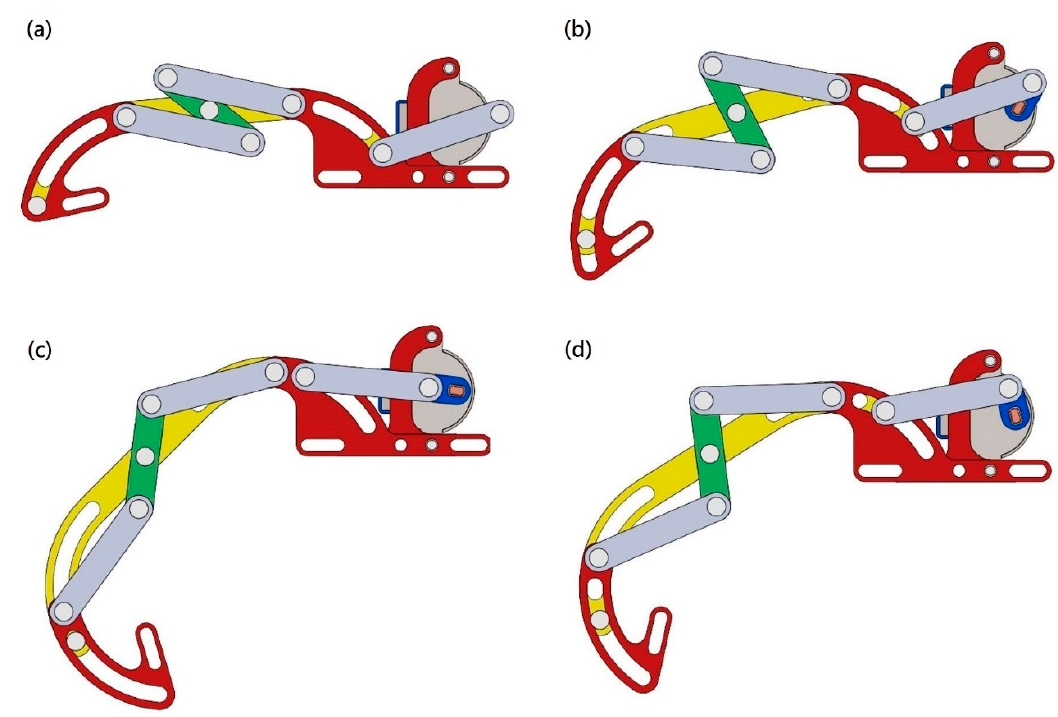
Figure 1. Design of the finger exoskeleton robot that allows the finger to curl from ( a ) extended to ( d ) flexed. ( d ) The prototype robotic finger has three sliders, five links, ten bolts, and one motor. As the motor rotates, the blue crank moves the gray coupler forwards or backwards. The gray coupler pushes and pulls the yellow slider arm, making it move along the slot. When the yellow slider moves, this causes the green link, or N-shaped linkage, to rotate, which in turn causes the yellow and outer red sliders to move together. The N-shaped linkage continues to push and pull the outer red slider, causing it to move along the slot. The outer red slider connects to the human finger and causes it to bend.